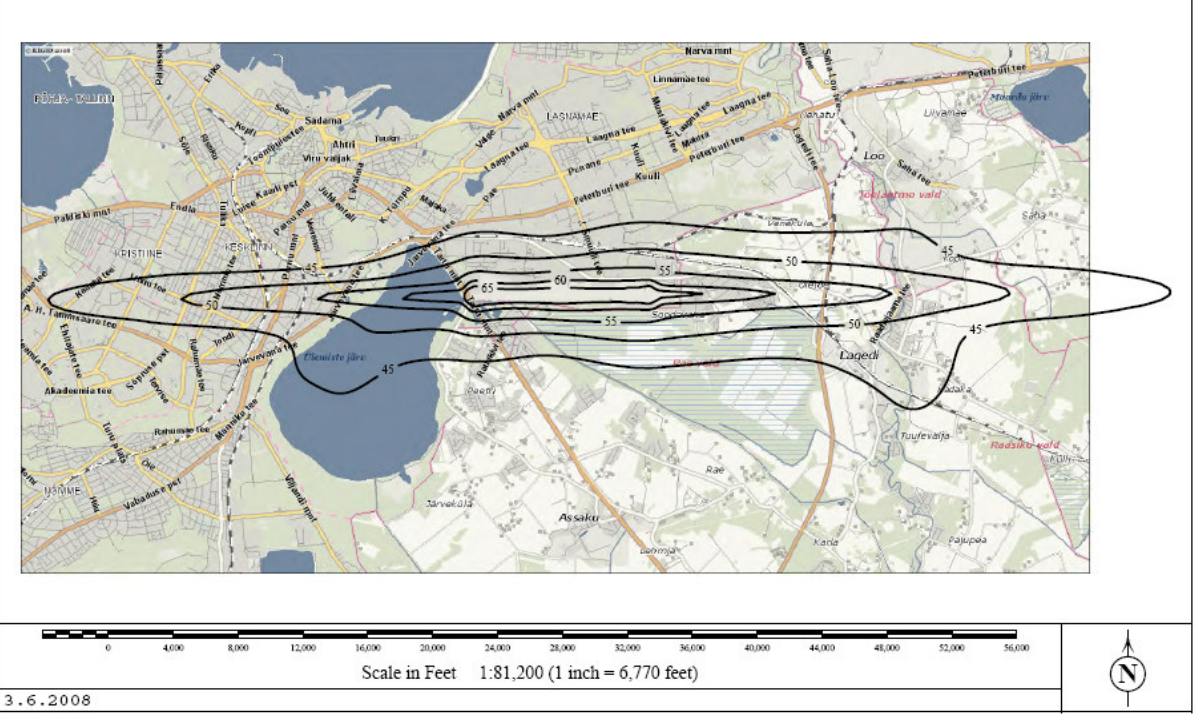
Fig 6. Tallinn Airport. Noise map according to Directive 2002/49/EC. Lday (7-23) noise contours. 2006 average